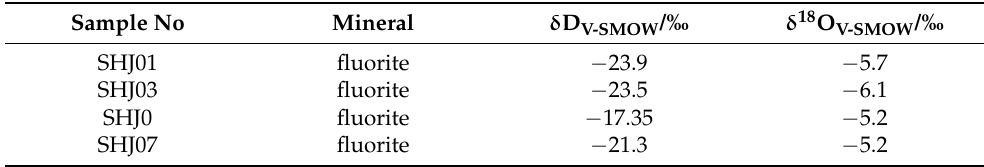
Table 5. Oxygen and hydrogen isotopic compositions of fluid inclusions from the Shuanghuajiang fluorite